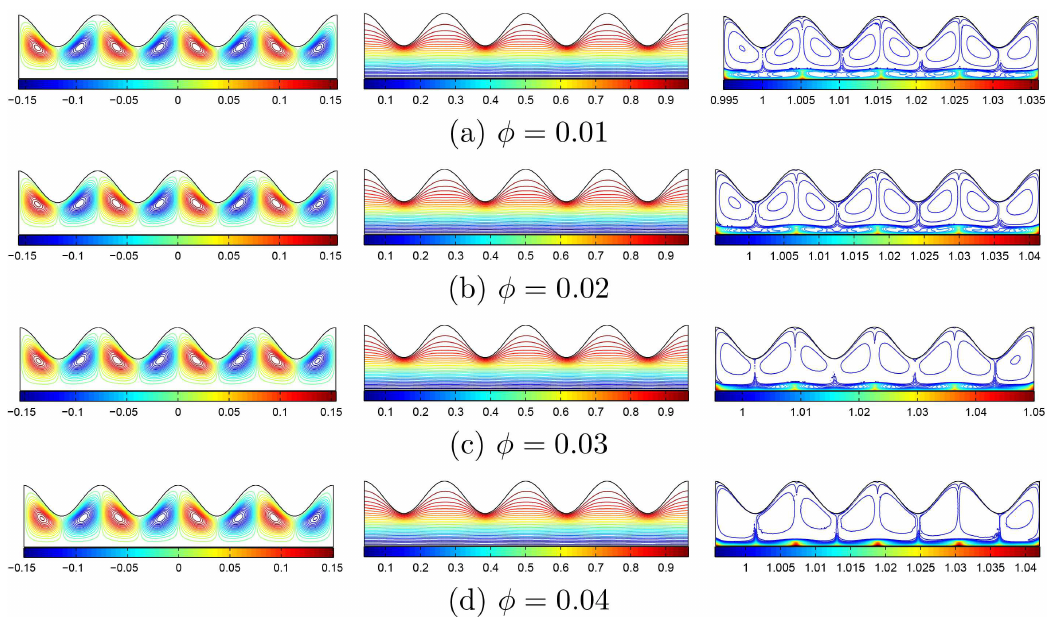
Figure 14. Variation of the streamlines ( left ), isotherms ( middle ), and nanoparticle distribution ( right ) evolution by solid volume fraction ( φ ) for N = 4, A = 0.1, and Ra = 10 6 in the plane ( X , Y